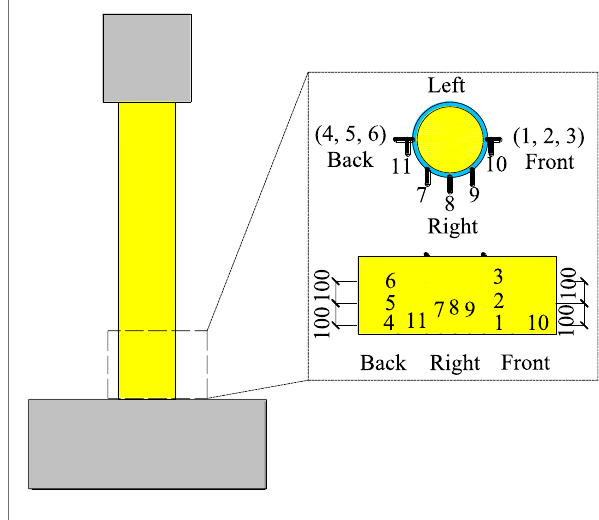
FIGURE 3 | Test measure equipment.